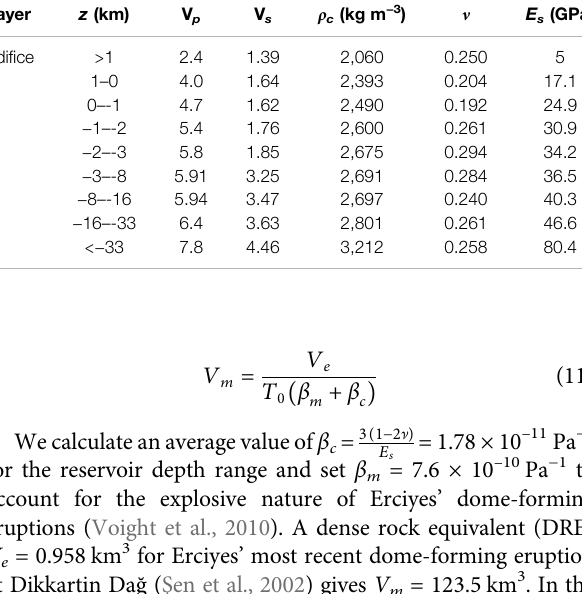
Table 3 are applied to invoke subsurface mechanics. Dirichlet